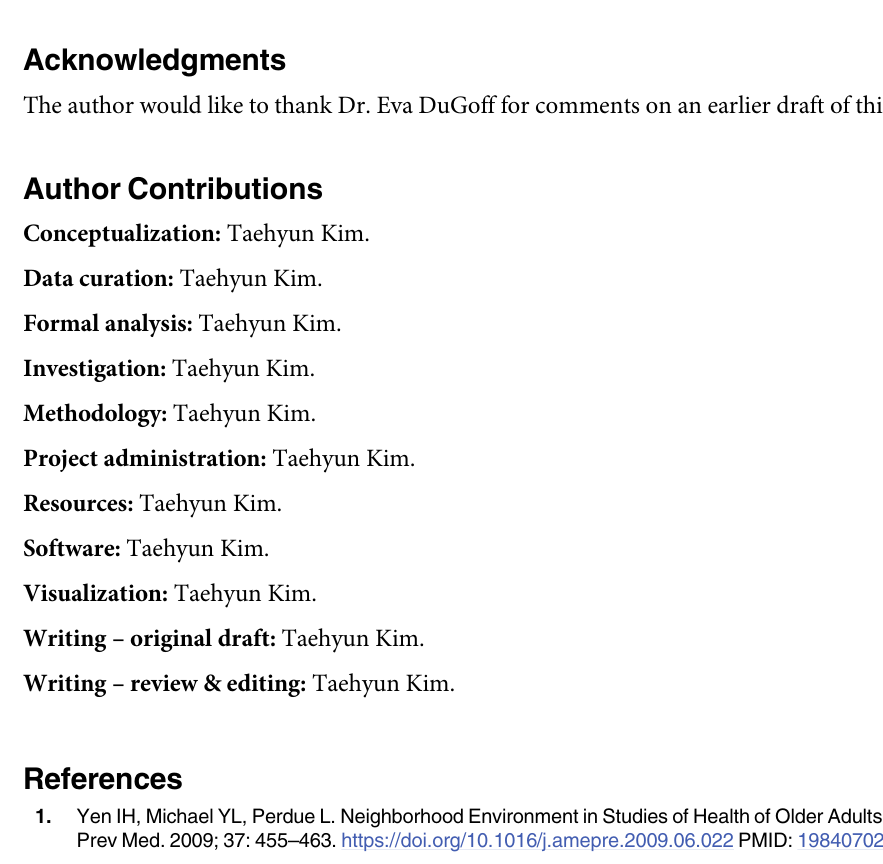
S2 Table. Regression results with multiple imputation. Note: � p < 0.1; �� p < 0.05; ��� p < 0.01. Source: Medicare Health Outcomes Survey 2014–2015. S3 Table. Descriptive characteristics comparing those with valid income values and those with missing income. Source: Medicare Health Outcomes Survey 2014–2015. S4 Table. Descriptive characteristics comparing those with valid homeownership values and those with missing homeownership. Source: Medicare Health Outcomes Survey 2014– 2015. S5 Table. Regression results with and without interaction terms between income/homeow- nership and neighborhood status. Source: Medicare Health Outcomes Survey 2014–2015. S6 Table. Bivariate analysis on income and mortality. Source: Medicare Health Outcomes Survey